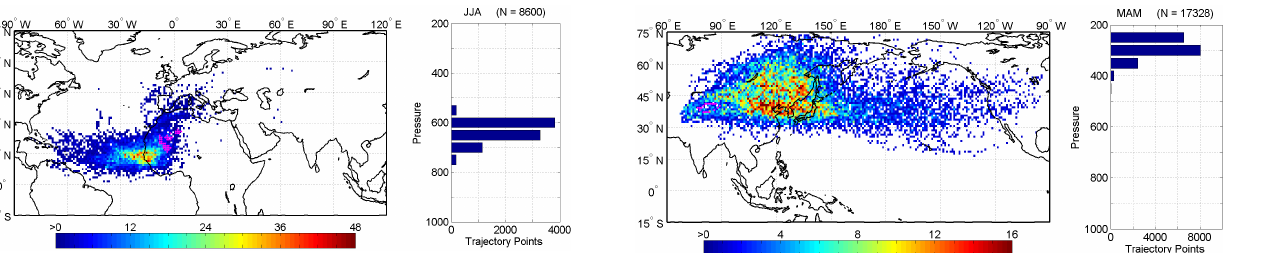
Fig. 12. CIRRUS’ cloud points originating from Taklimakan desert (perimeter shown in magenta) in